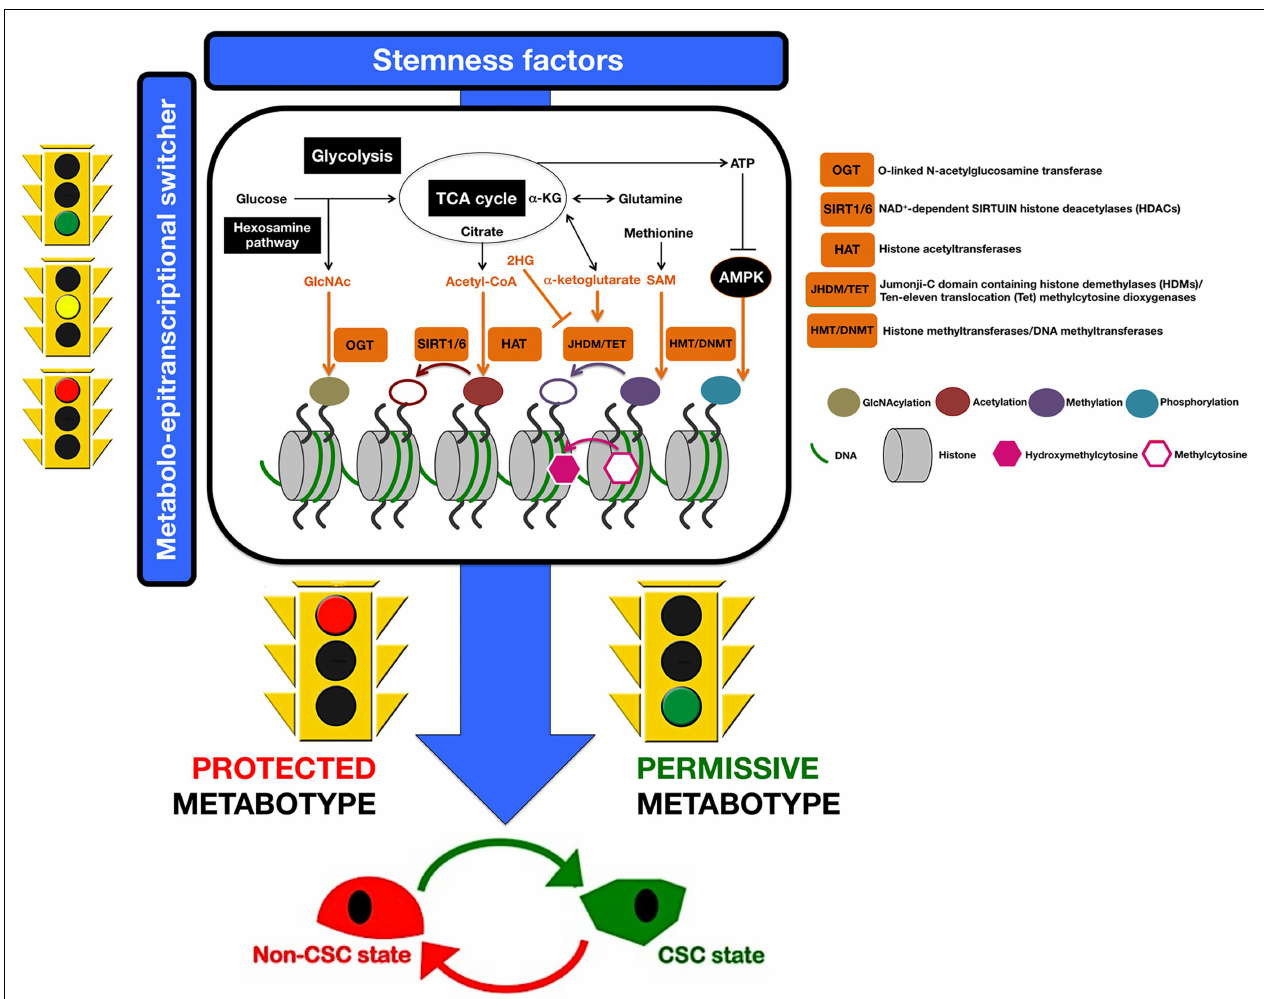
FIGURE 3 | Metabostemness: a metabolo-epitranscriptional switcher . A highly active crosstalk between metabolism and epigenetics allows the causal integration of metabolism and metabolites with genetic programs to coordinately regulate CSC function and fate. Nutrient levels and cell metabolism will significantly affect levels of the metabolites, which are required substrates of chromatin-modifying enzymes that use them to modify both histones and DNA (116). A minor portion of the lucose that enters the glycolytic pathway is branched to hexosamine biosynthetic pathway to produce GlcNAc, a substrate for histone GlcNAcylation by the OGT enzyme. It is well known that the flux through glycolysis determines the NAD + /NADH ratio, a crucial metabolic parameter for the activities of sirtuin histone deacetylases. Citrate and α -ketoglutarate ( α -KG) are intermediates of theTCA cycle that can be exported out of mitochondria; cytosolic citrate is converted to acetyl-CoA that is employed as a donor for HAT-mediated histone acetylation. JHDM andTET use α -KG as cofactor for histone and DNA demethylation reactions, respectively. S-adenosylmethionine (SAM), which